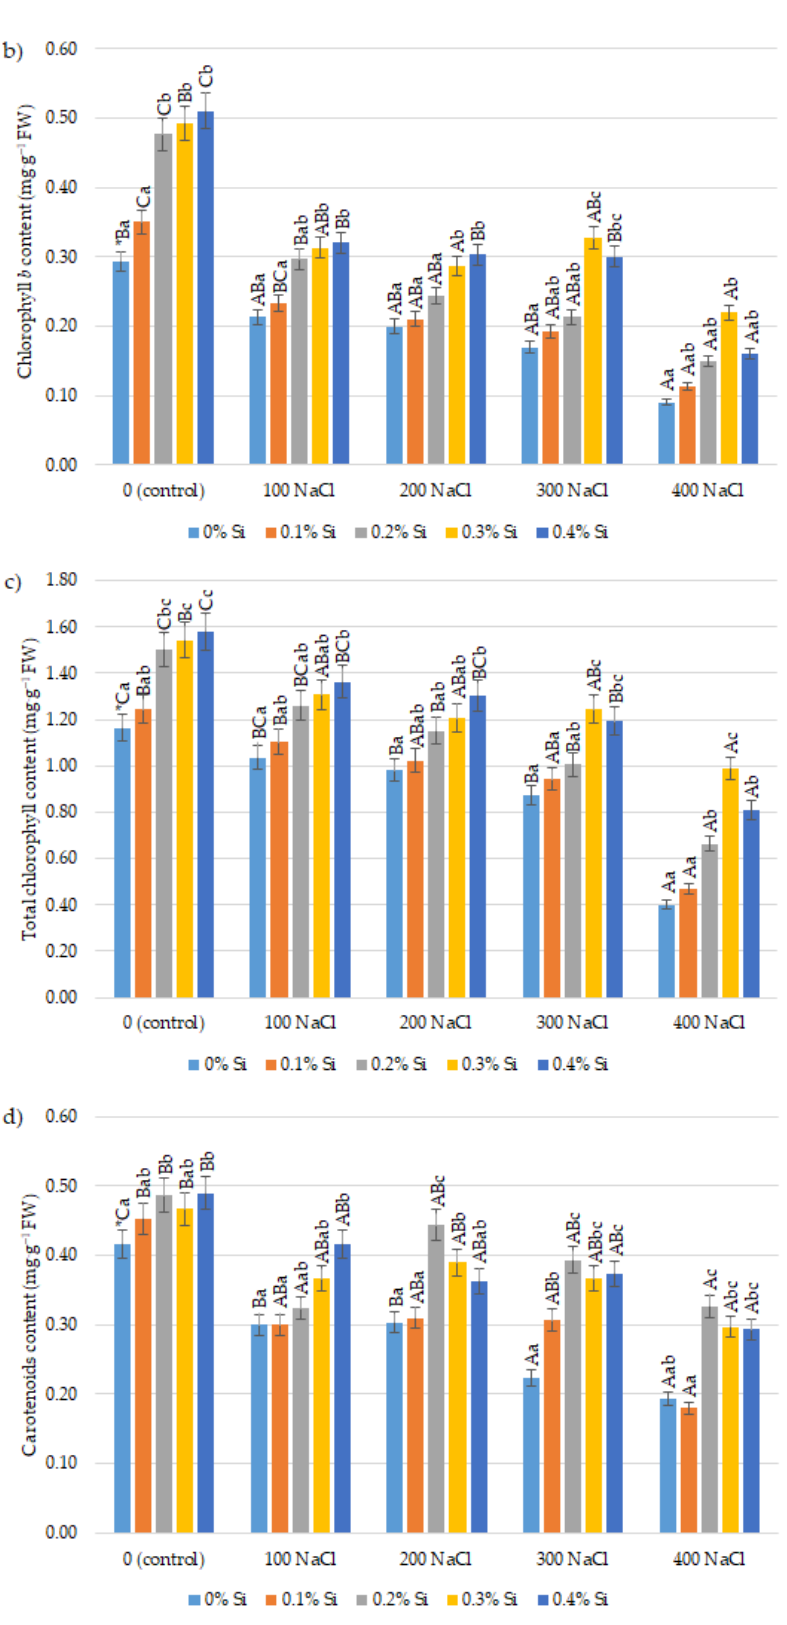
Figure 4. The effect of Si on the chlorophyll a ( a ), b ( b ), total ( c ) and carotenoids ( d ) content in maize leaves cultivated in varying salinity conditions. * Capital letters indicate significant differences between the means for soil salinity at the same doses of Si, and lowercase letters represent the mean significant differences between the doses of Si at the same salinity ( p = 0.05).